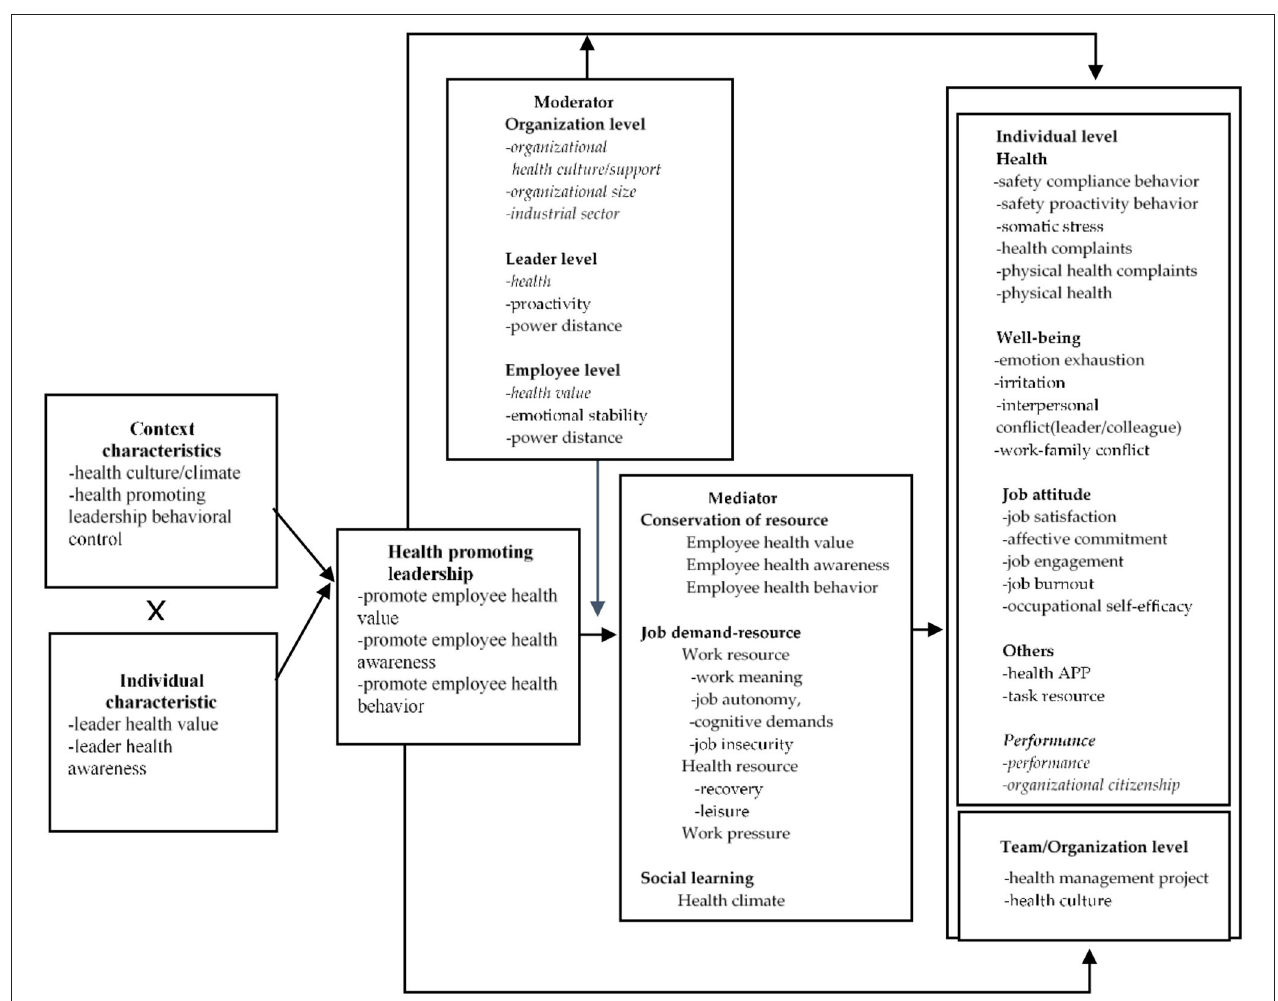
FIGURE 2 | Research framework for health-promoting leadership. Italics indicate future